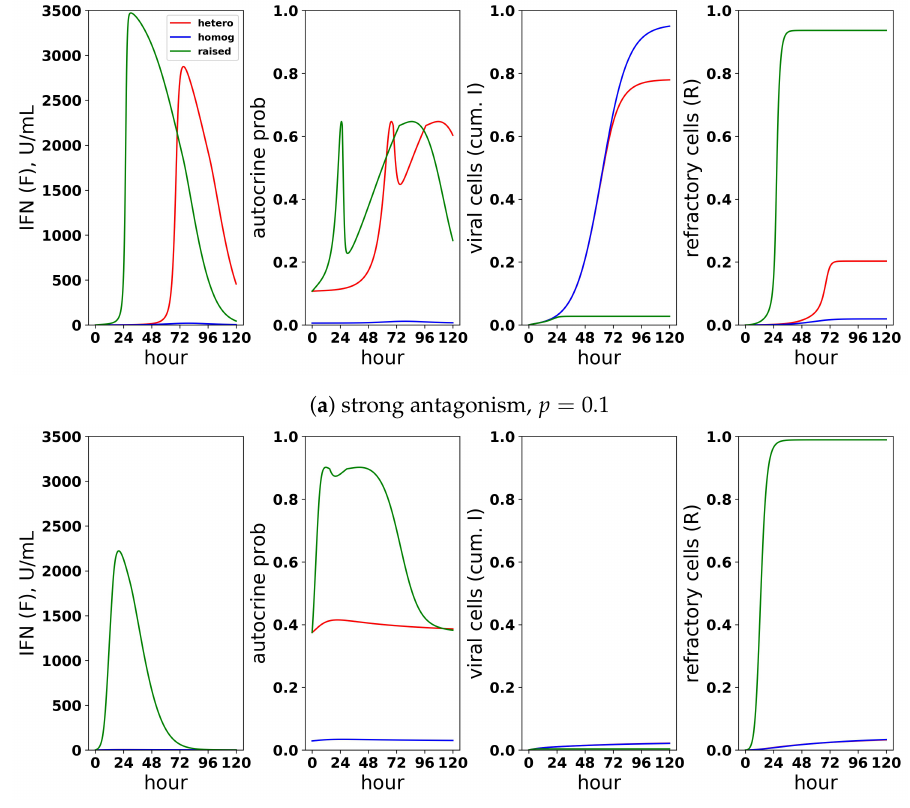
Figure 14. A scaled heterogeneous response protects eclipse cells through autocrine-mediated signaling, while not excessively raising paracrine-mediated signaling to target cells. We considered a scaled heterogeneous response, a homogeneous response and a response in which we raised secretion rates, but did not restrict the fraction of cells that could induce IFN. ( a ) In the presence of strong antagonism and an infectivity rate p = 0.1, the feedback loop is activated, and extracellular IFN concentration rises for the heterogeneous and raised responses, but not for the homogeneous response. Rising extracellular IFN levels are mediated by strong autocrine signaling, which leads to a high probability that eclipse cells transform into effector cells (autocrine prob). Activation of the feedback loop leads to a lower frequency of viral cells and a higher frequency of refractory cells, particularly for the raised response. ( b ) In the absence of antagonism and an infectivity rate p = 0.01, the heterogeneous and homogeneous feedback loops do not activate, but the feedback loop activates for the raised response. For all three responses, viral cells have low frequency, but the raised response transforms nearly all target cells into refractory cells and raises extracellular IFN levels to 2000 U/mL, reflecting excessive IFN